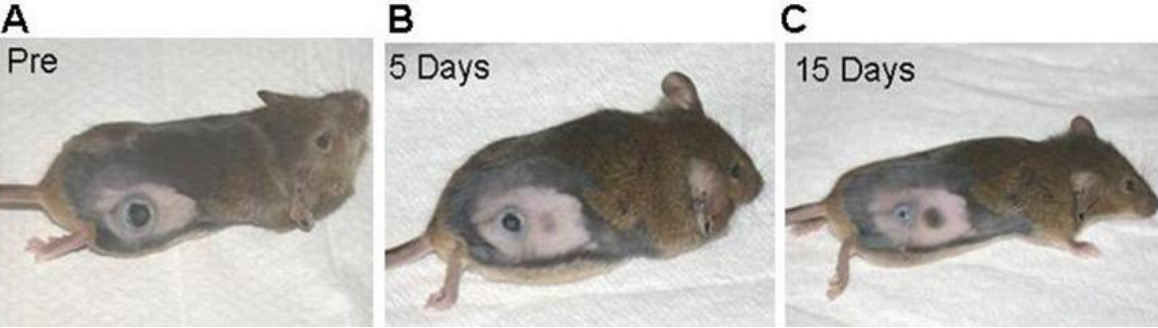
Figure 4. Effect of injected 1.0 mg  -gal glycolipids on tumor growth. ( A ) Pre-treated tumor; ( B ) Tumor on day 5 post  -gal glycolipids injection; ( C ) Tumor on day 15 post injection. Note the gradual regression of the tumor. The black spot developing in the skin near the regressing tumor was caused by a subcutaneous administration of  -gal glycolipids into normal skin, inducing local inflammation that results in transient activation of normal